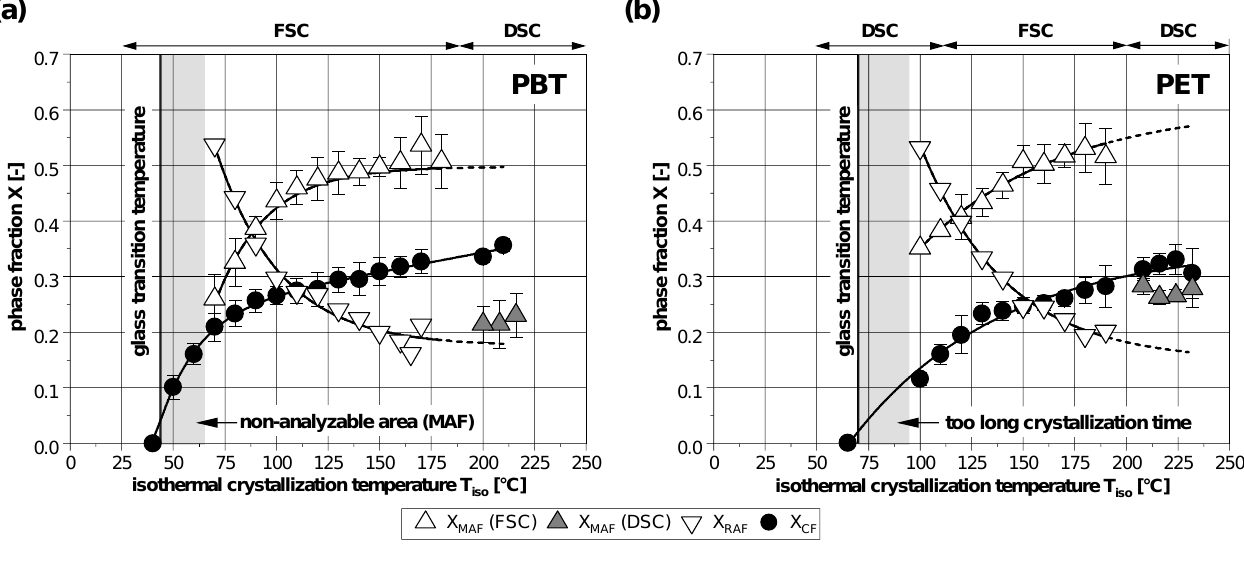
Figure 4. Determined phase composition of ( a ) PBT and ( b ) PET in dependence on the isothermal crystallization temperature. The lines are for visual purposes